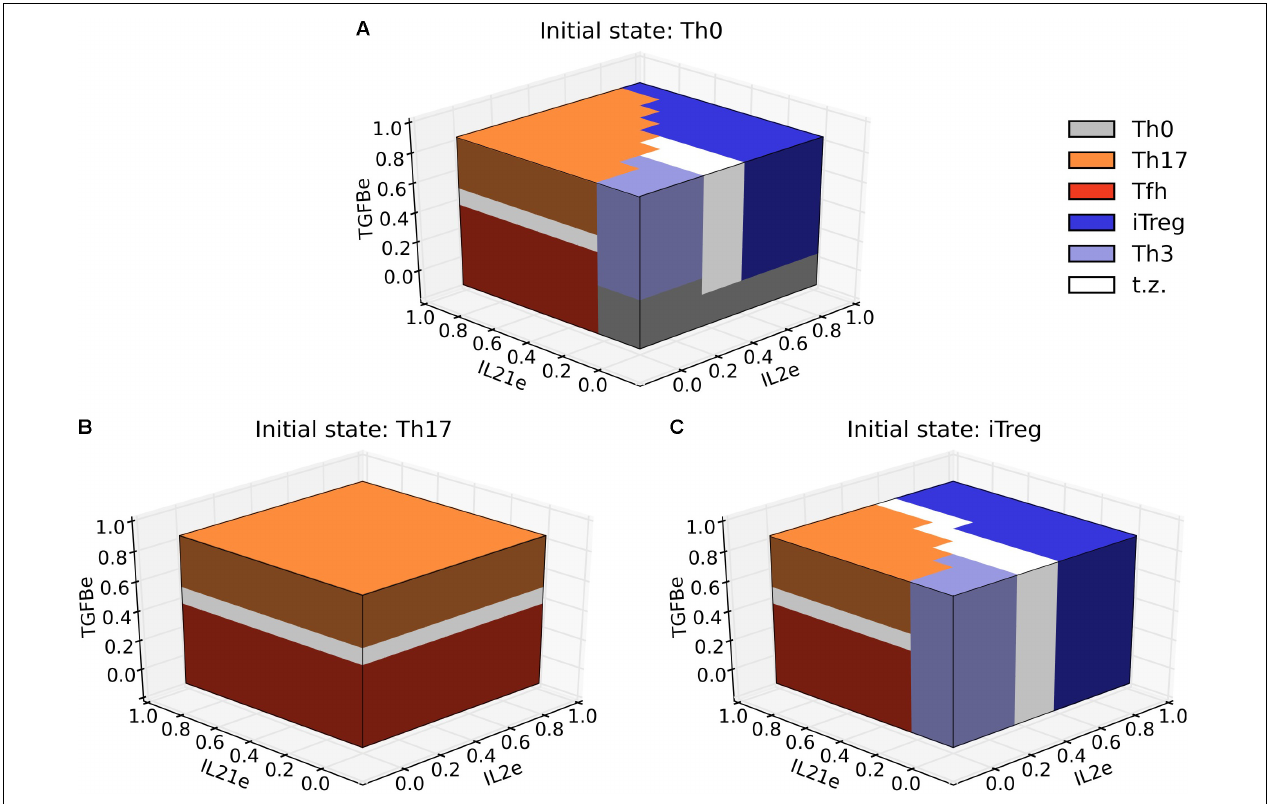
FIGURE 6 | Three-dimensional phenotype space diagrams for Th17 and iTreg polarization and plasticity as a function of the relative concentrations of IL2, IL21, and TGFB in the microenvironment. In the differentiation diagram (A) we observe alternative phenotypic regions defined by relative concentrations of environmental cytokines. The regions may be either separated by a sharp boundary or by a more gradual transition zone (labeled in white). The plasticity diagram (B) indicates a polarized behavior for Th17 versus Tfh phenotype determined by a high or low concentration of external TGFB. A richer behavior ensues when the initial state is Treg, as shown in the plasticity diagram (C) . We observe a similar structure as that depicted in A , except that the Th0 zone is